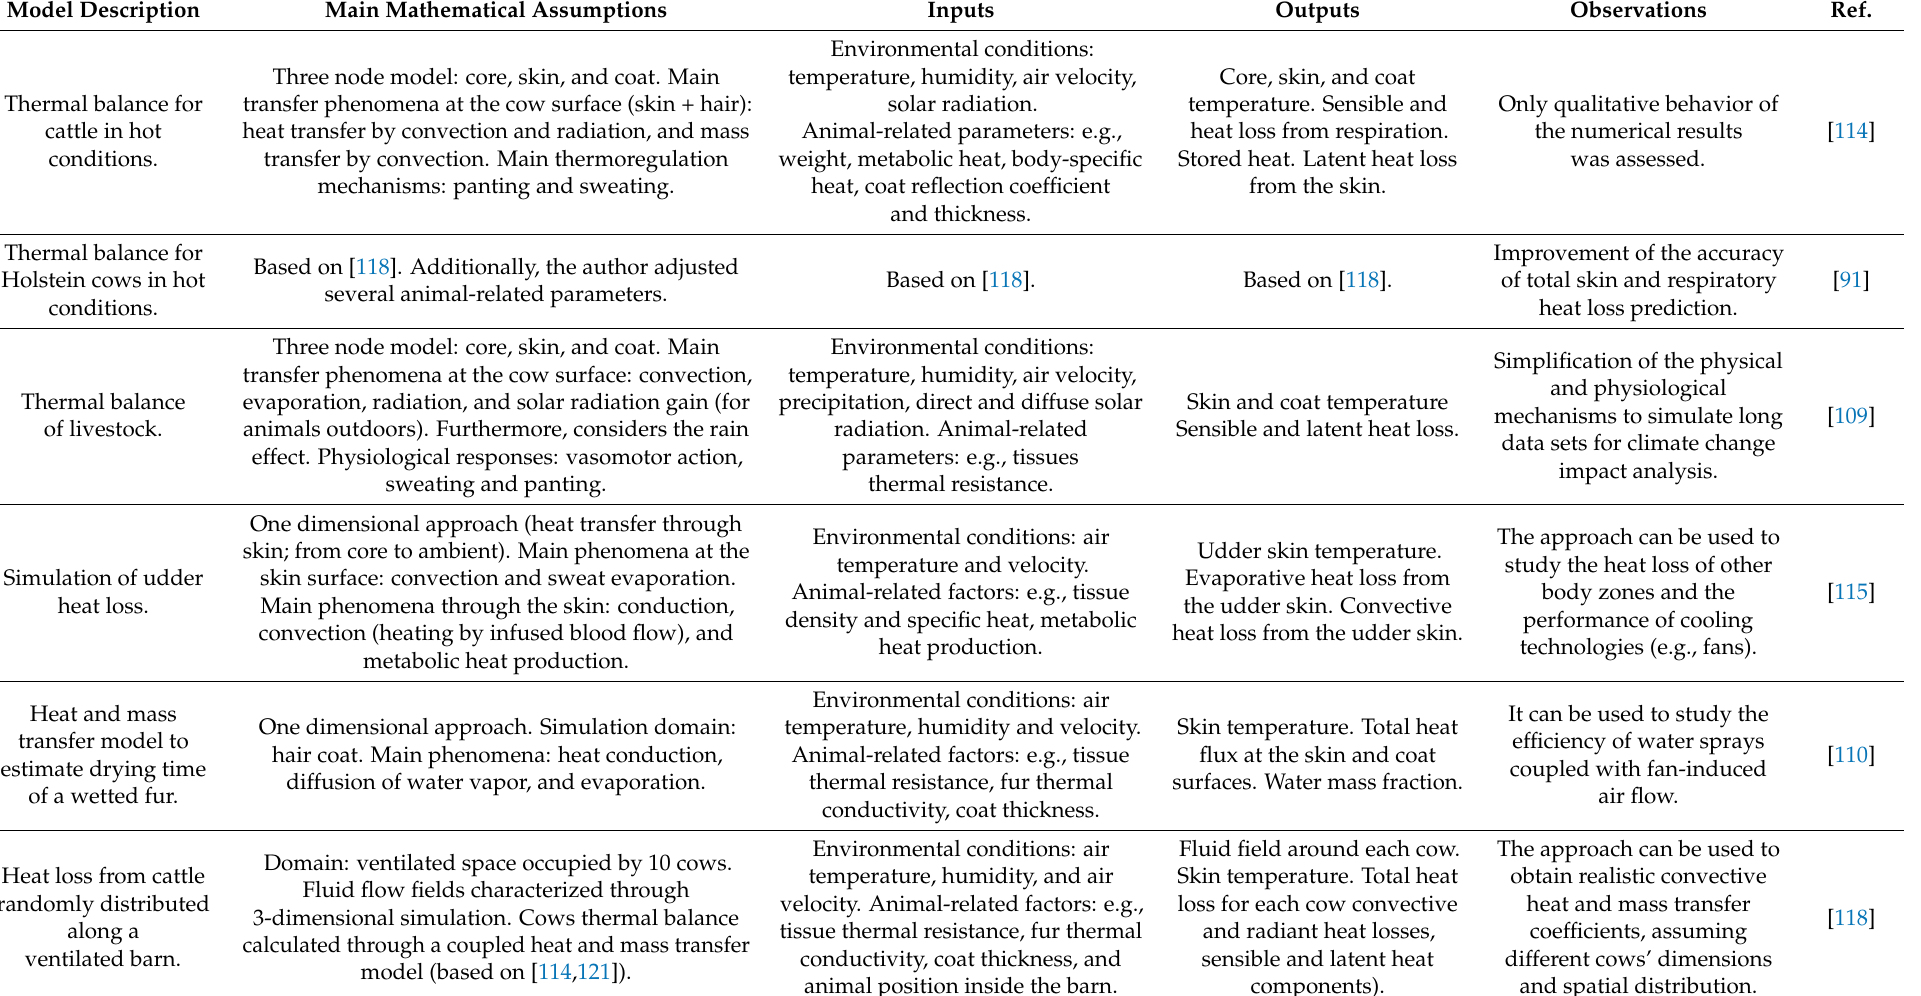
Table 3. Example of mechanistic model studies and the corresponding input and output